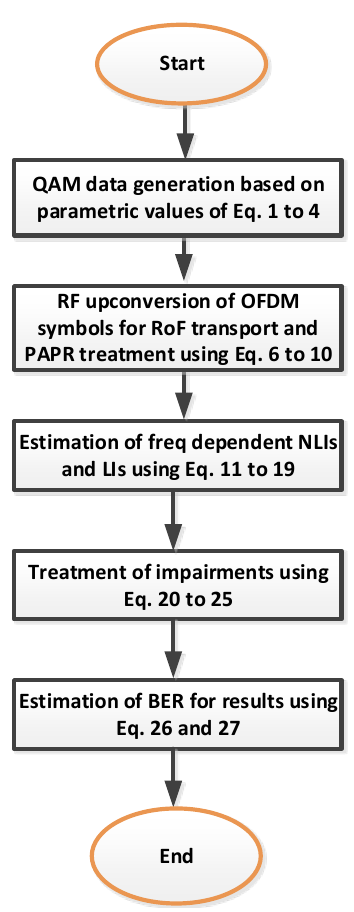
Figure 2. Performance evaluation of the proposed system based on the analytical model in Section 3.